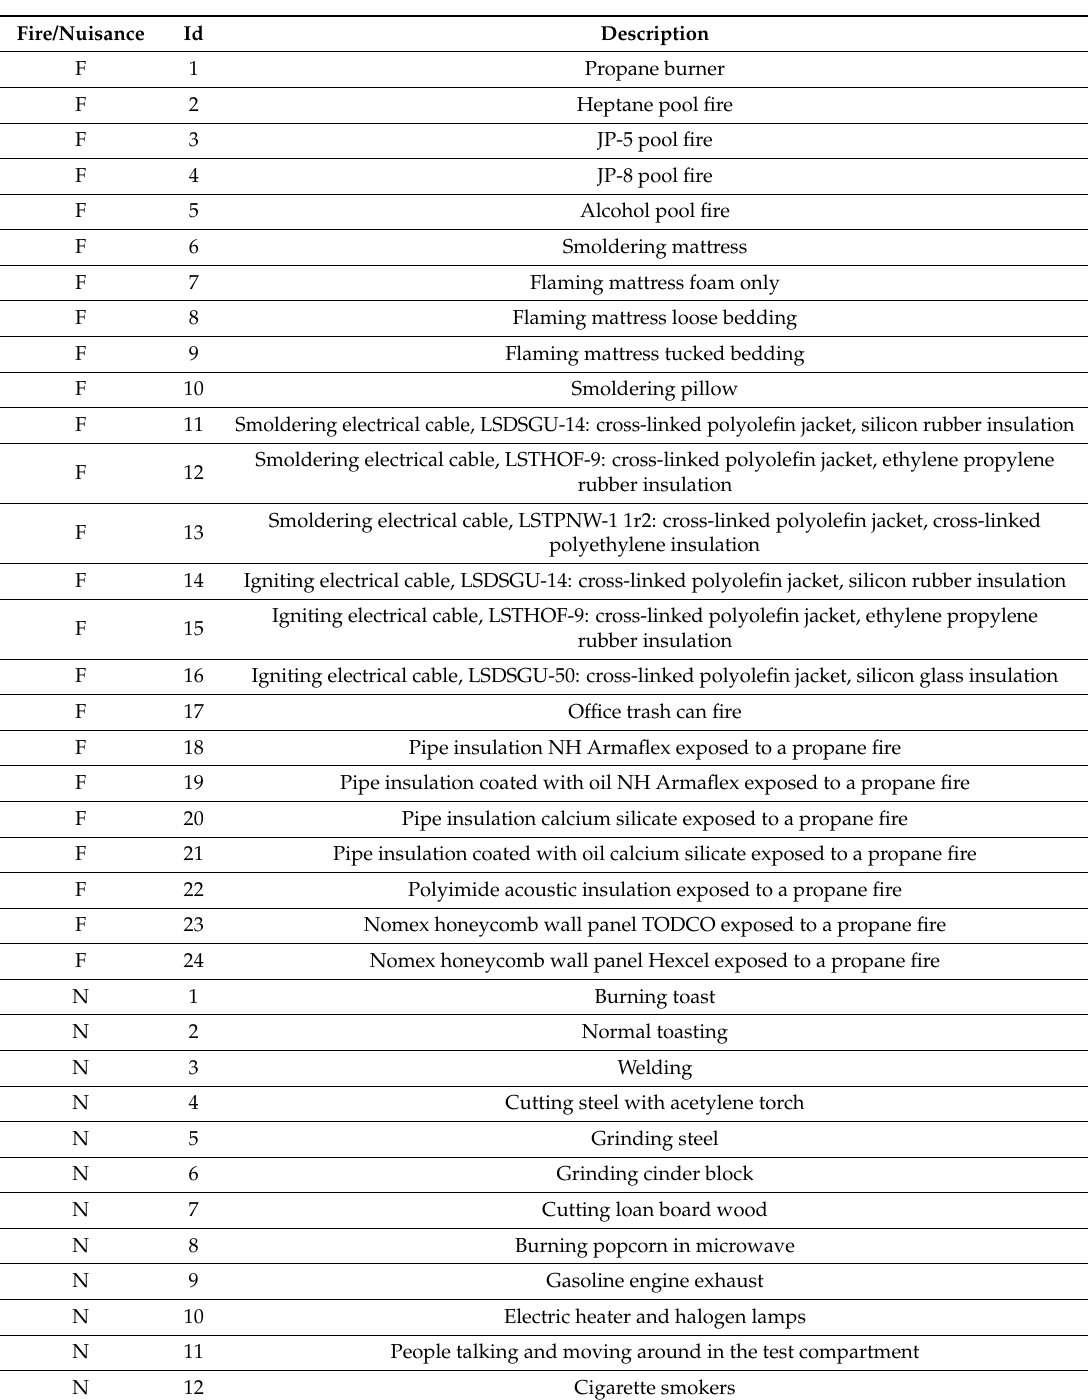
Table 7. Rose-Pehrsson et al. considered a very complete set of fire/nuisances scenarios, with various repetitions of each, for a total number of 240 measurements (120 background, 82 fires and 38 nuisance sources). Table adapted from